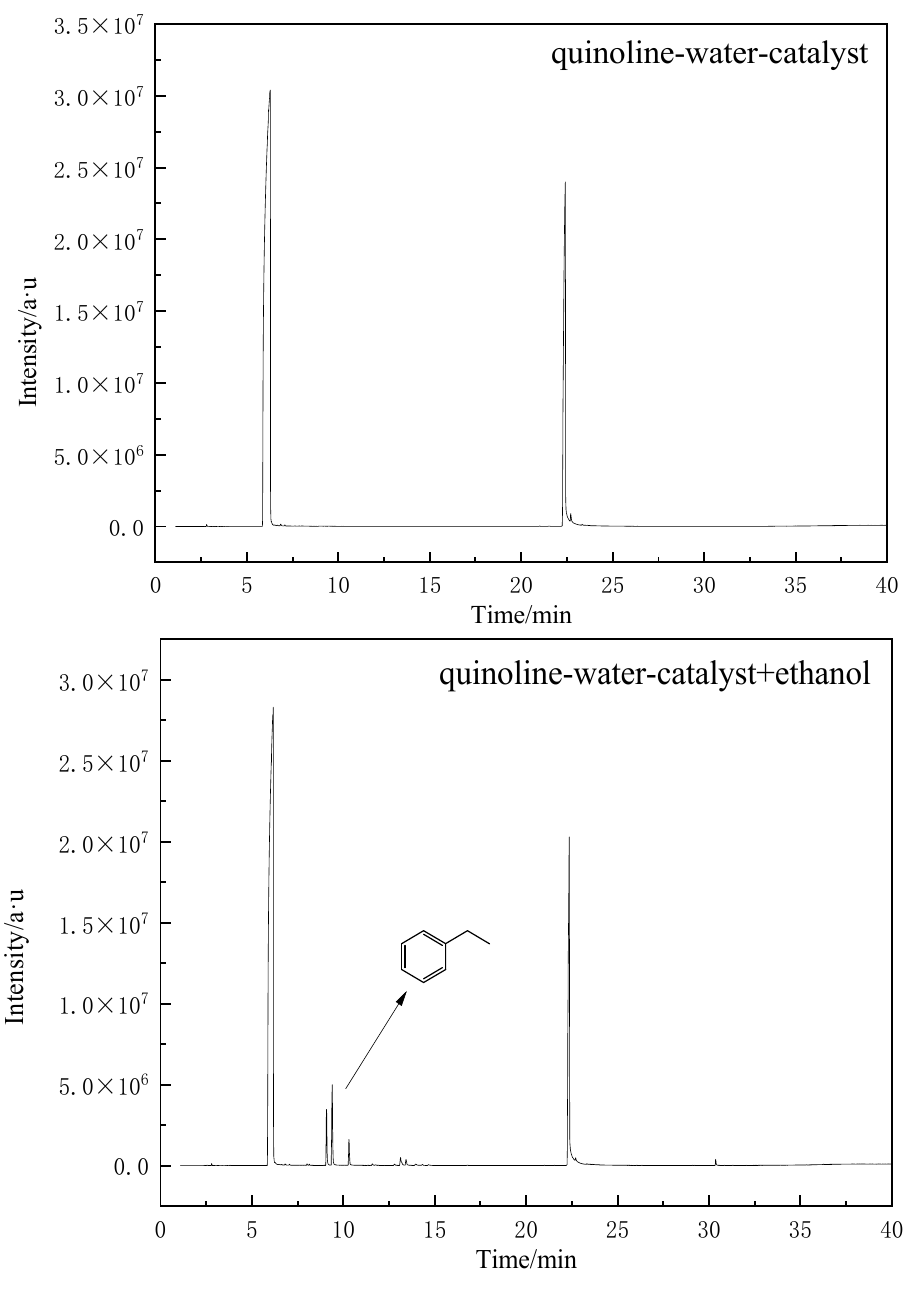
Figure 14 . GC curves of quinoline under different reaction conditions. Figure 14. GC curves of quinoline under different reaction